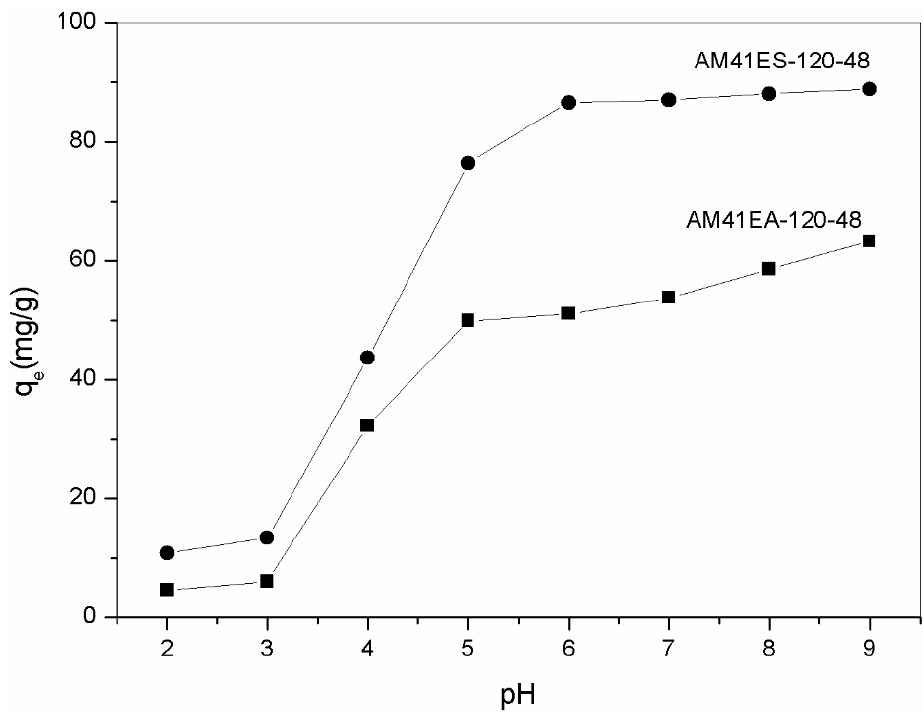
Figure 10. Adsorption capacity of AM41ES-120-48 and AM41EA-120-48 for Pb(II) at different pH. Experimental conditions: adsorption temperature T = 25 °C, adsorbent dose m = 50 mg, solution volume V = 50 mL, contact time t = 200 min, pH = 2, 3, 4, 5, 6, 7, 8, and 9, and initial Pb(II) concentration C 0 = 100 mg/L.